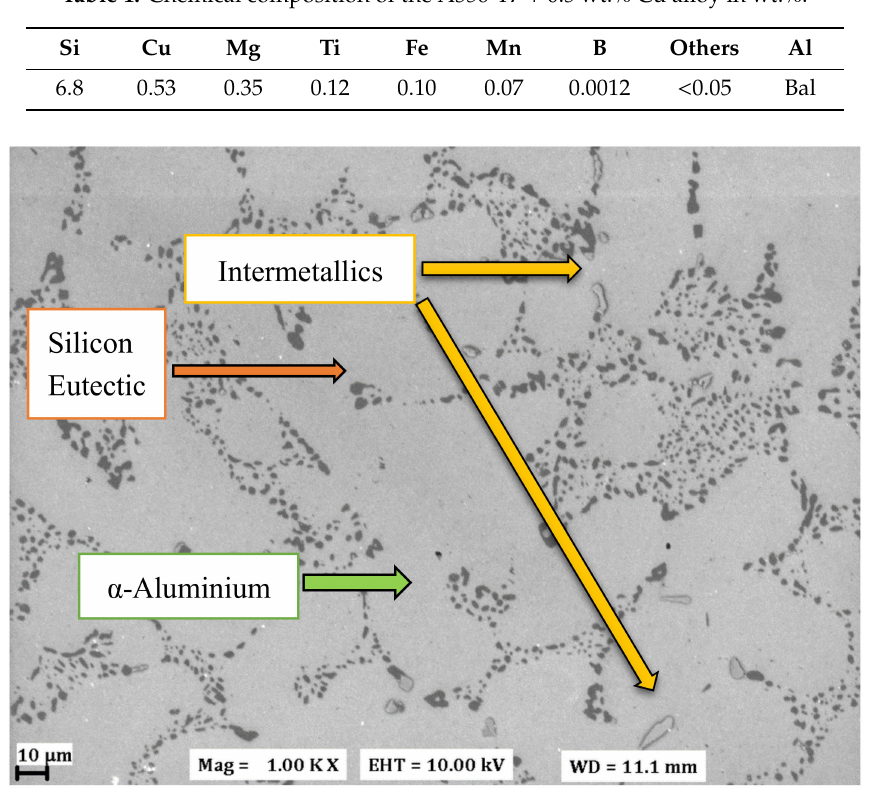
Table 1. Chemical composition of the A356-T7 + 0.5 wt.% Cu alloy in wt.%.